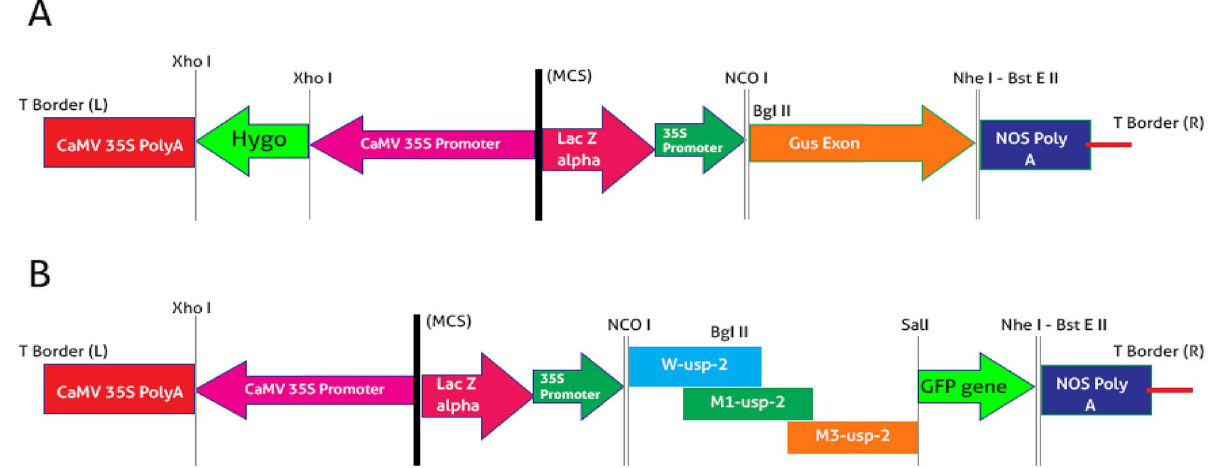
Figure 1. ( A ) pCAMBIA-1301 vector with hygromycin and ( B ) pCAMBIA-1301b vector without hygromycin and with wild type & mutated GUSP-2 genes (cloned